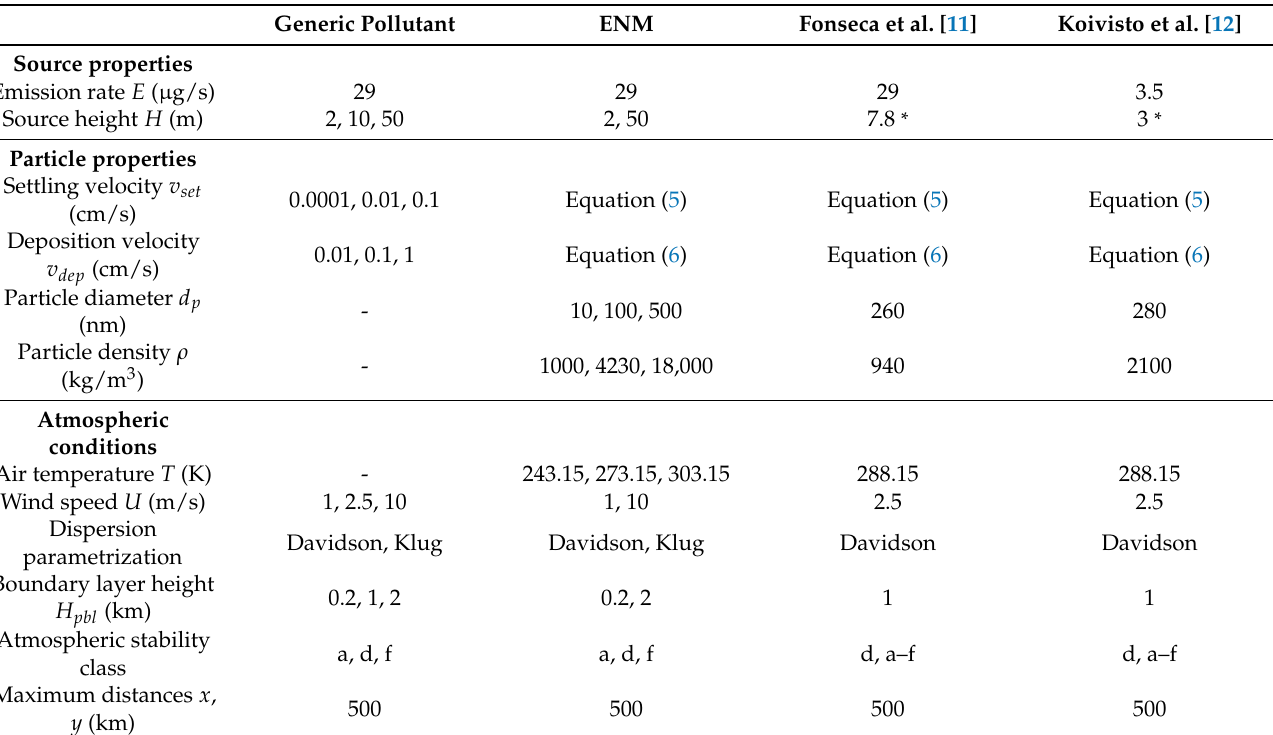
Table 1. The ADiDeNano dispersion model parameter values for simulations of a generic pollutant, ENMs and case studies. Generic Pollutant ENM Fonseca et al.